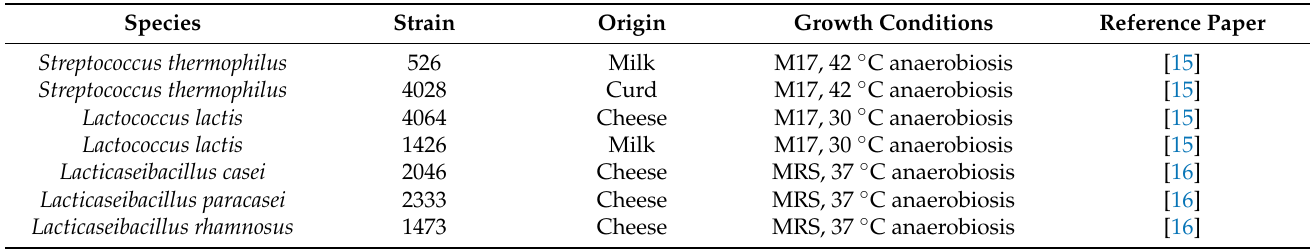
Table 1. Strains, origin and growth